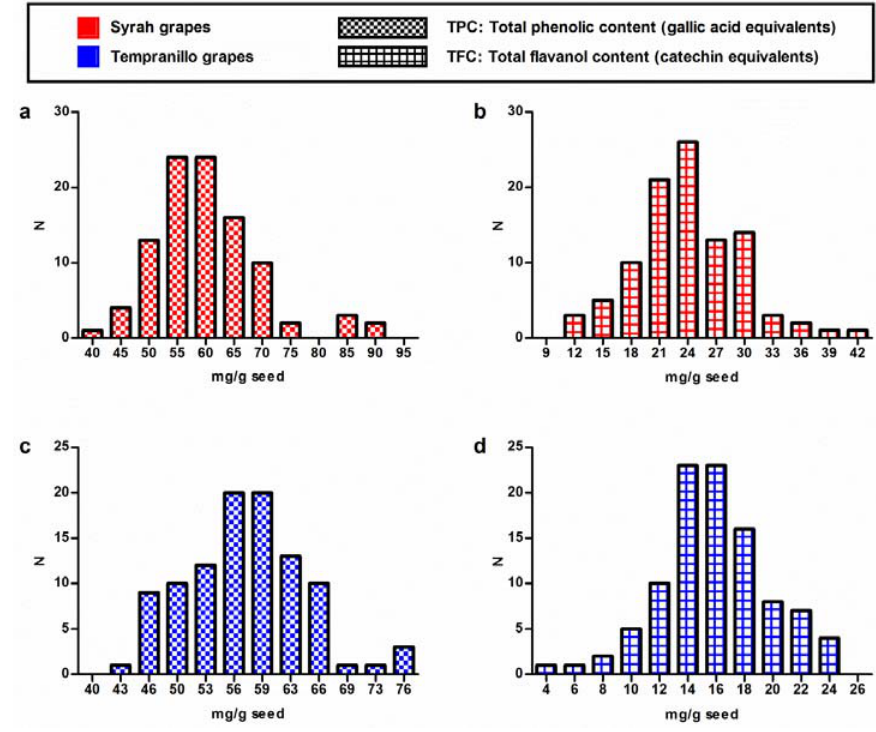
Figure 4. Distributions of Syrah and Tempranillo grape seeds in different total phenolic content ( a , c ) and total flavanolic content ( b , d ).